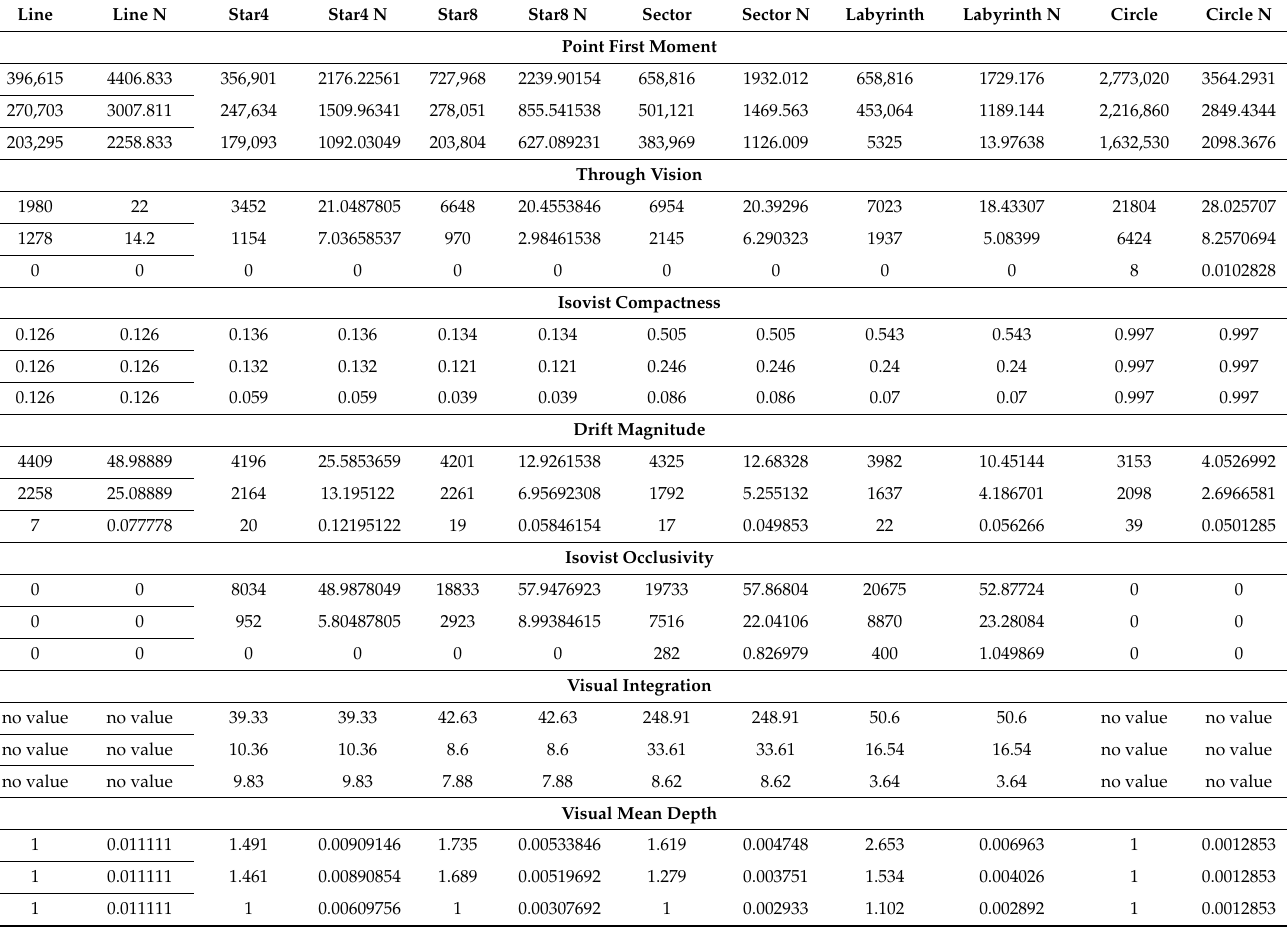
Table 6. Basic meta-pattern value measures (MAX, MEAN, MIN) and their normalization (N).